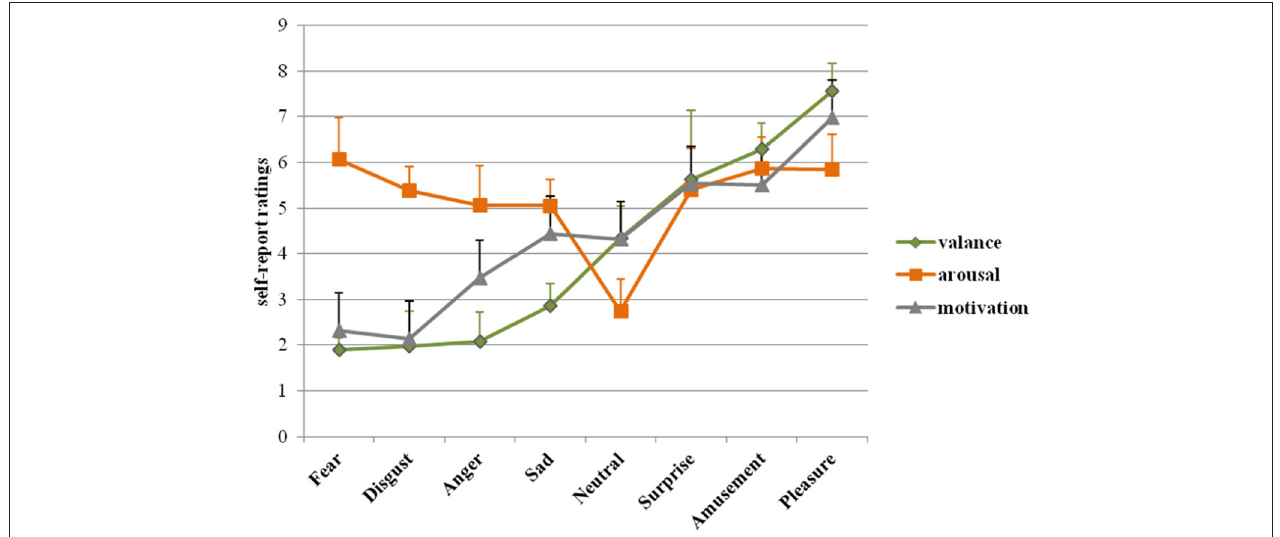
FIGURE 2 | The rank of each category on valence, arousal and motivation. (The rank is based on the results of